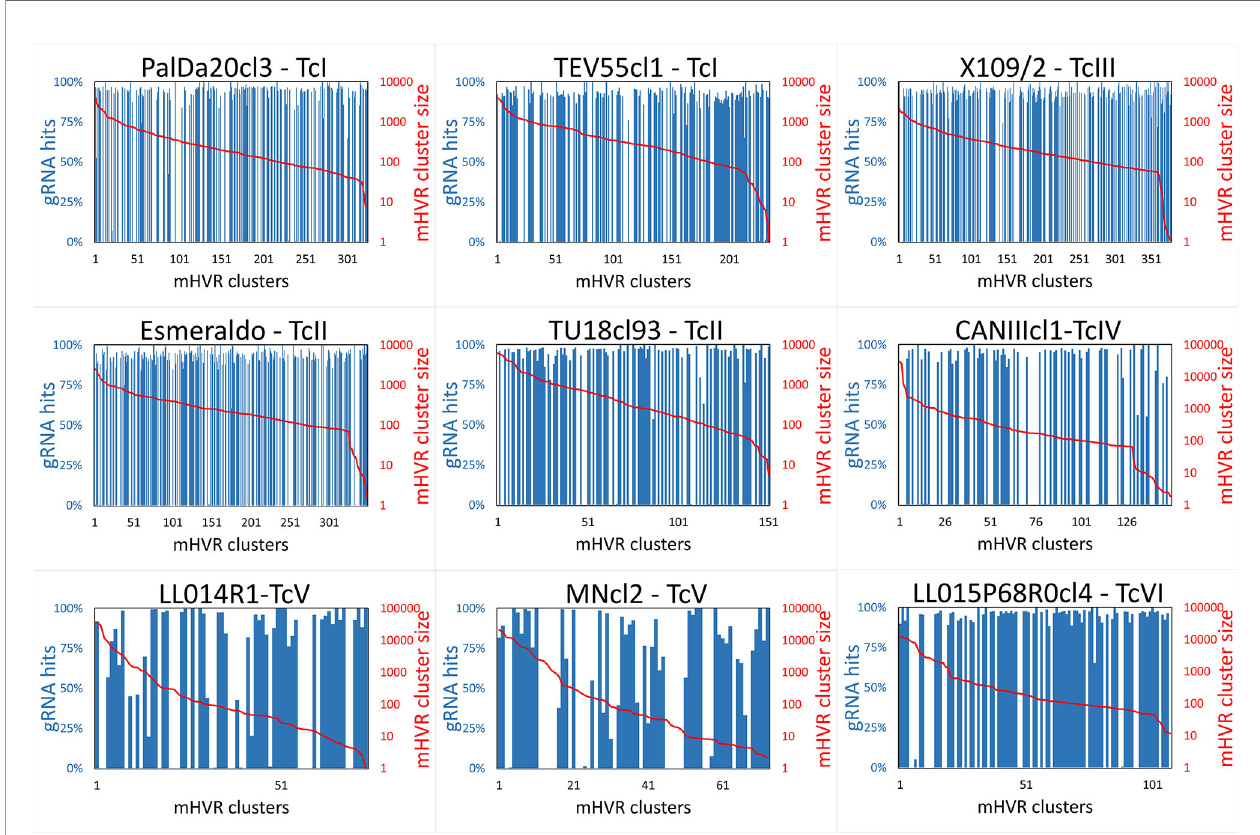
FIGURE 3 | The number of mHVR sequences in a cluster is not related to the coding of gRNAs. mHVR clusters were graphed in decreasing order according to their size (mHVR cluster size is indicated with a solid redline). Each blue bar indicates the percentage of reads in the mHVR cluster in which a gRNA was identi fi ed (gRNA hits). Red color indicates percentage of reads in the mHVR cluster where gRNAs were not